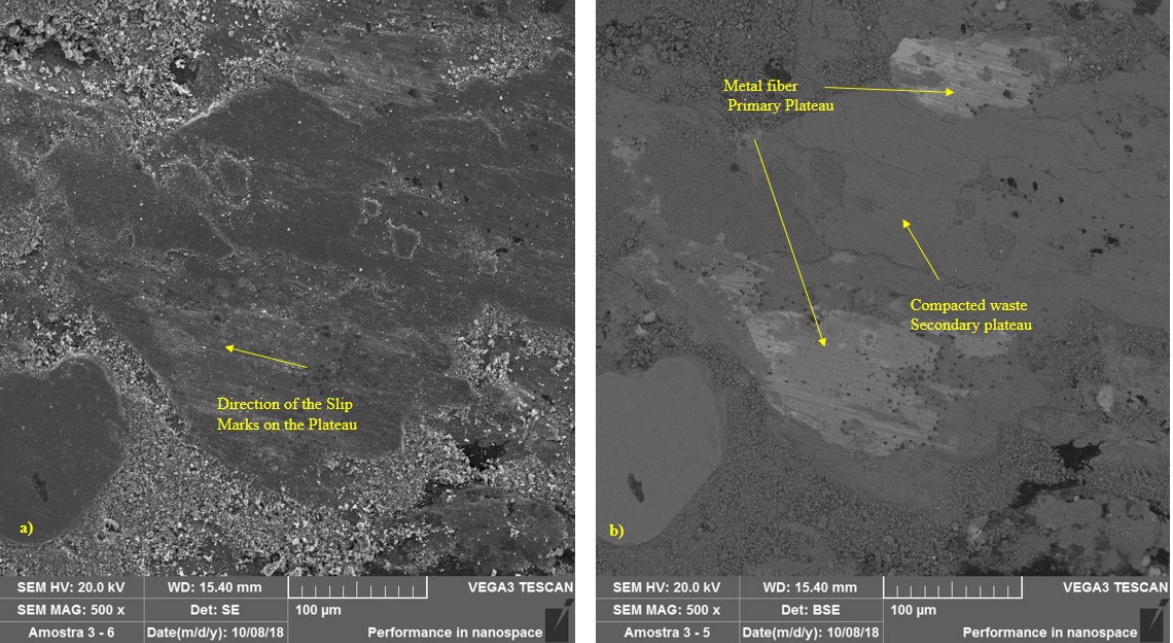
Figure 9. SEM images—500 × —for pad under emergency braking: ( a ) SE; ( b ) BSE. Figure 10 represents the EDS chemical characterization performed at different points